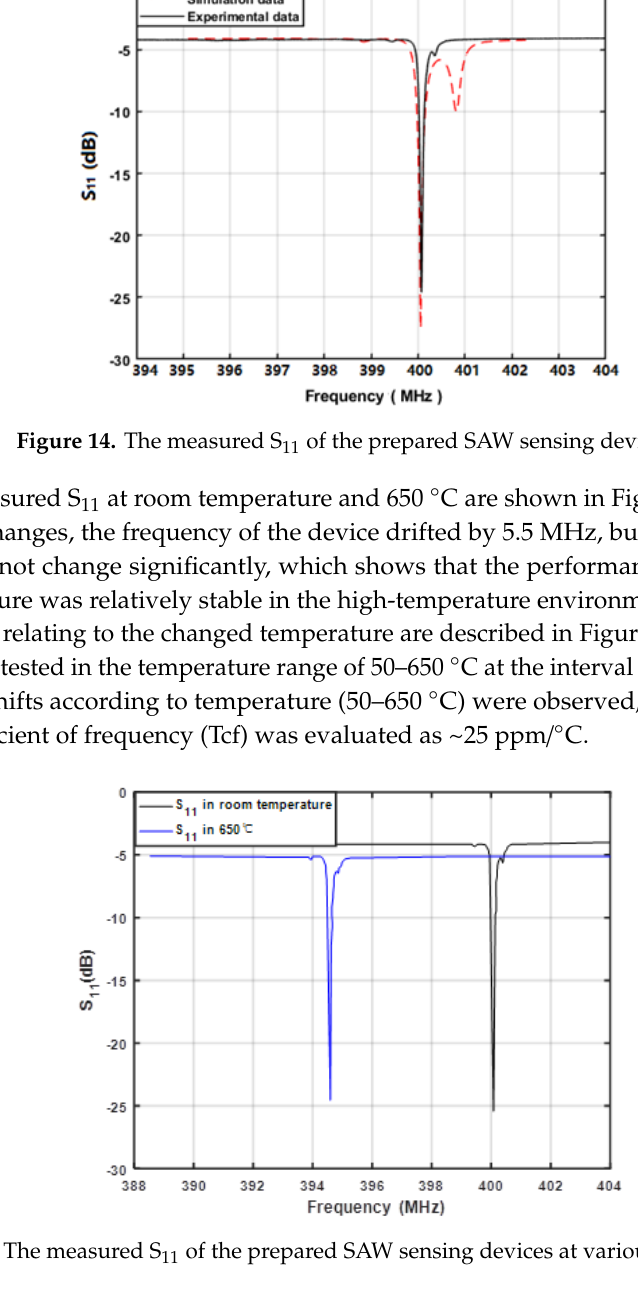
Figure 16. The measured frequency shift according to temperature (50 – 650 °C).